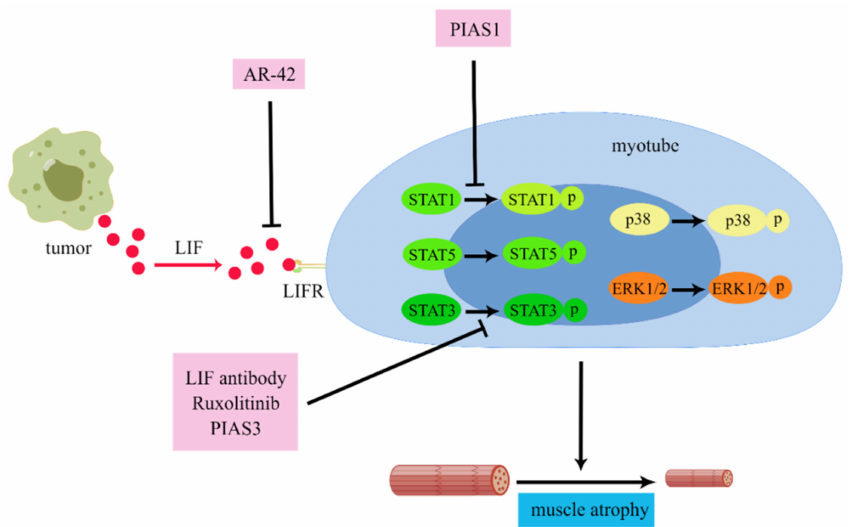
Figure 4. The mechanisms of LIF in cachexia-induced skeletal muscle atrophy. LIF targeted at myotubes can activate STAT1, STAT3, STAT5, ERK1/2, and p38 signaling. PIAS1 can block STAT1 phosphorylation to inhibit muscle atrophy. The LIF antibody, Ruxolitinib (JAK inhibitor), and PIAS3 can block the phosphorylation of STAT3 to inhibit muscle atrophy. Additionally, AR-42, a histone deacetylation inhibitor, can block LIF to treat CAC-induced muscle atrophy (by Figdraw “www.figdraw.com”, accessed on 5 May